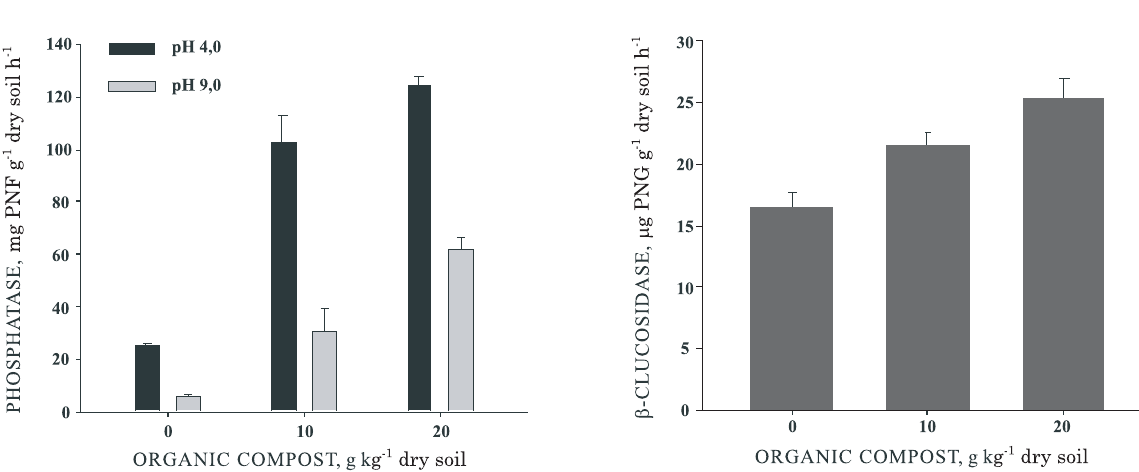
(1) Soil with 10 g kg -1 of compost in the soil. (2) Soil with 20 g kg -1 of compost. (3) Total glucose: soil sugar converted to C (1 glucose